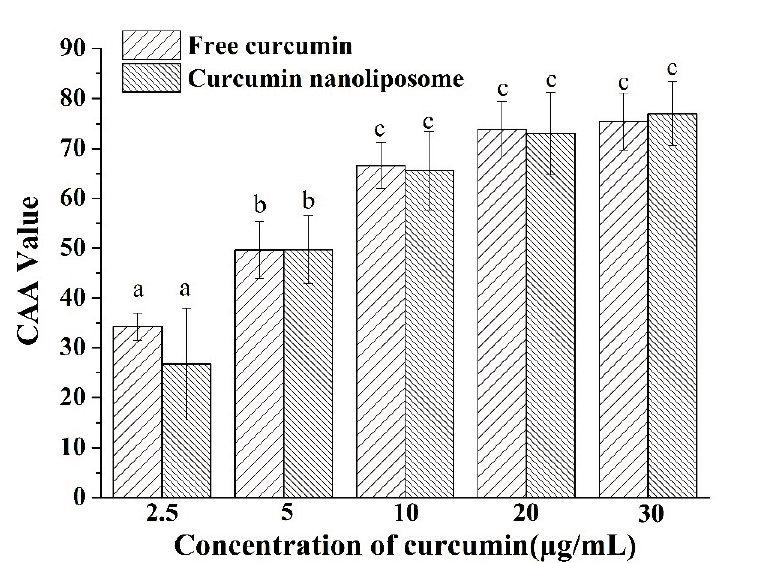
Figure 8. Celluar antioxidant activity of free curcumin and curcumin